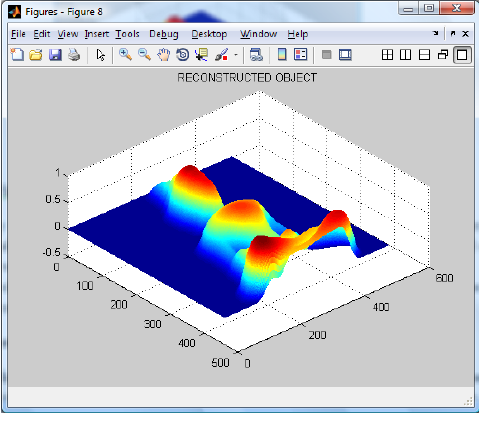
Figure 7. Reconstructed object using our Extended Wavelet Transform Profilometry.